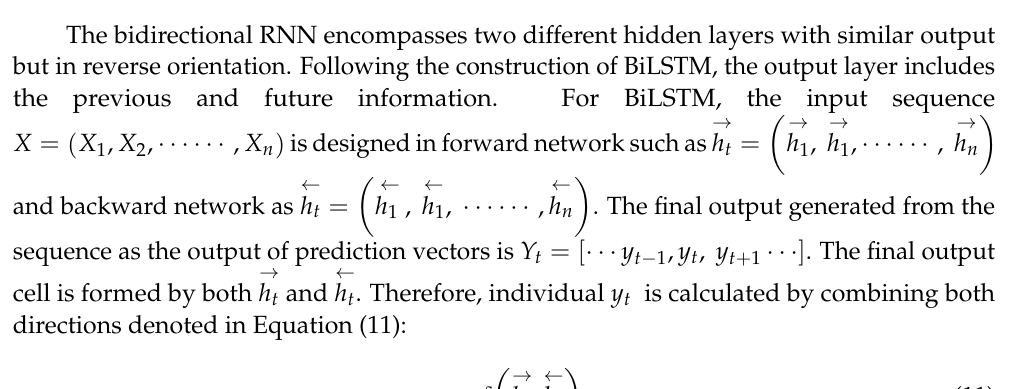
Figure 4. Architecture of Bi-LSTM.